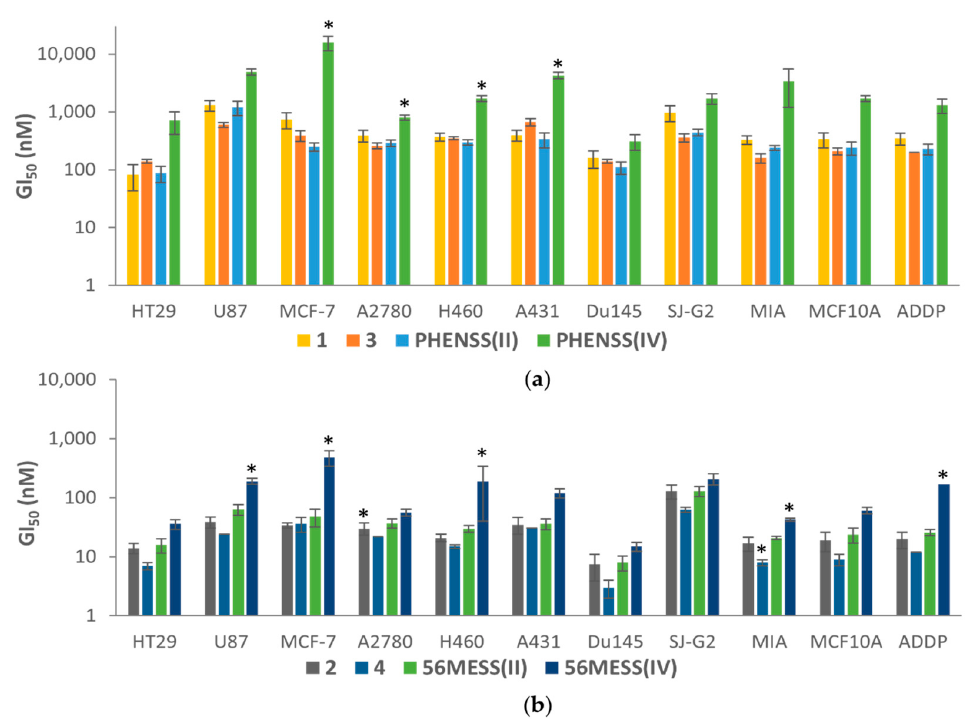
Figure 6. The GI 50 values of ( a ) 1 , 3 , PHENSS(II) and PHENSS(IV) , and ( b ) 2 , 4 , 56MESS(II) and 56MESS(IV), across several cancer cell lines after 72 h drug exposure. GI 50 values (nM) are the mean and reported with standard error of the mean; results are produced from three independent experiments. Significant differences between the compounds and PHENSS(II) or 56MESS(II) are shown as *, at p < 0.05.